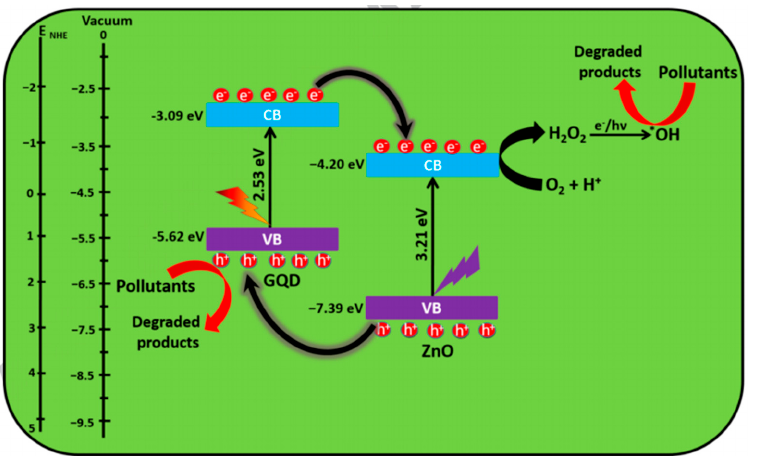
Figure 3. Schematic illustration of energy band diagram and a proposed mechanism of the charge carrier transitions in ZnO–GQD composite towards photocatalytic pollutant degradation under nat- ural sunlight irradiation.